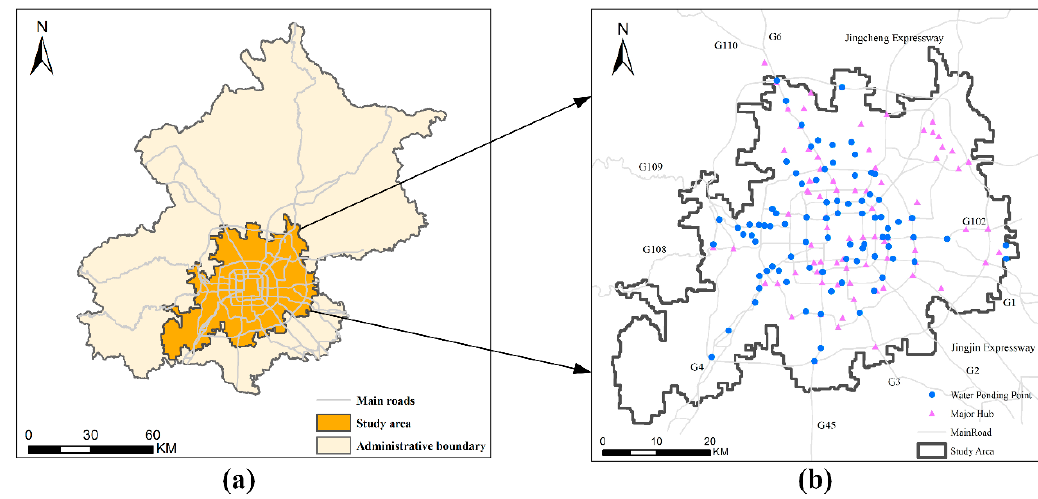
Figure 1. A map showing the boundary of our study area. Location of the study area in Beijing ( a ) and overview of the study area ( b ).